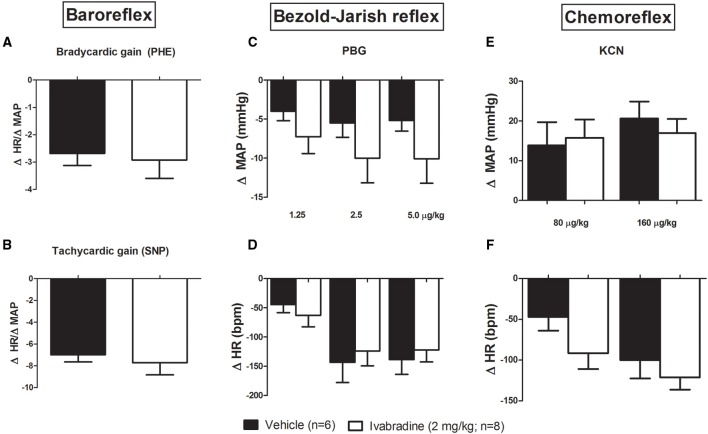
Effects of chronic treatment with ivabradine on the reflex control of the heart rate in non-anesthetized Wistar rats. (A) Baroreflex bradycardic gain and (B) baroreflex tachycardic gain, respectively, induced by phenylephrine (PHE: 2, 4, and 8 μg/kg) and sodium nitroprusside (SNP: 4, 8, and 16 μg/kg, i.v.) injections. Baroreflex gains were obtained by ΔHR/ΔMAP index (bpm/mmHg), which was calculated through the mean of three used doses. Changes in mean arterial pressure (MAP, mmHg) and heart rate (HR, bpm) induced by (C,D) phenylbiguanide (PBG: 1.25; 2.5, and 5 μg/kg, i.v.) and (E,F) potassium cyanide (KCN: 80 and 160 μg/kg, i.v.) injections were performed to assess the Bezold-Jarish reflex and chemoreflex regulation, respectively, in non-anesthetized Wistar rats submitted to vehicle (PBS 1 mL/kg/day i.p.; single dose; n = 6) or ivabradine (2 mg/kg/day i.p.; single dose; n = 8) treatment during 8 days. Bars represent mean ± SEM of vehicle (VEH—black) and ivabradine (IVA—white) groups. p > 0.05, VEH vs. IVA (Student's unpaired t-test).